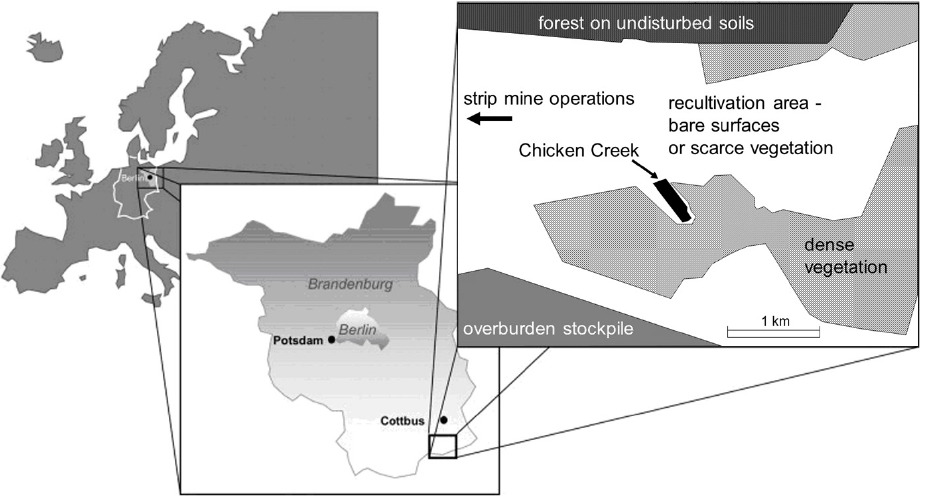
Fig. 1. Location of the artificial